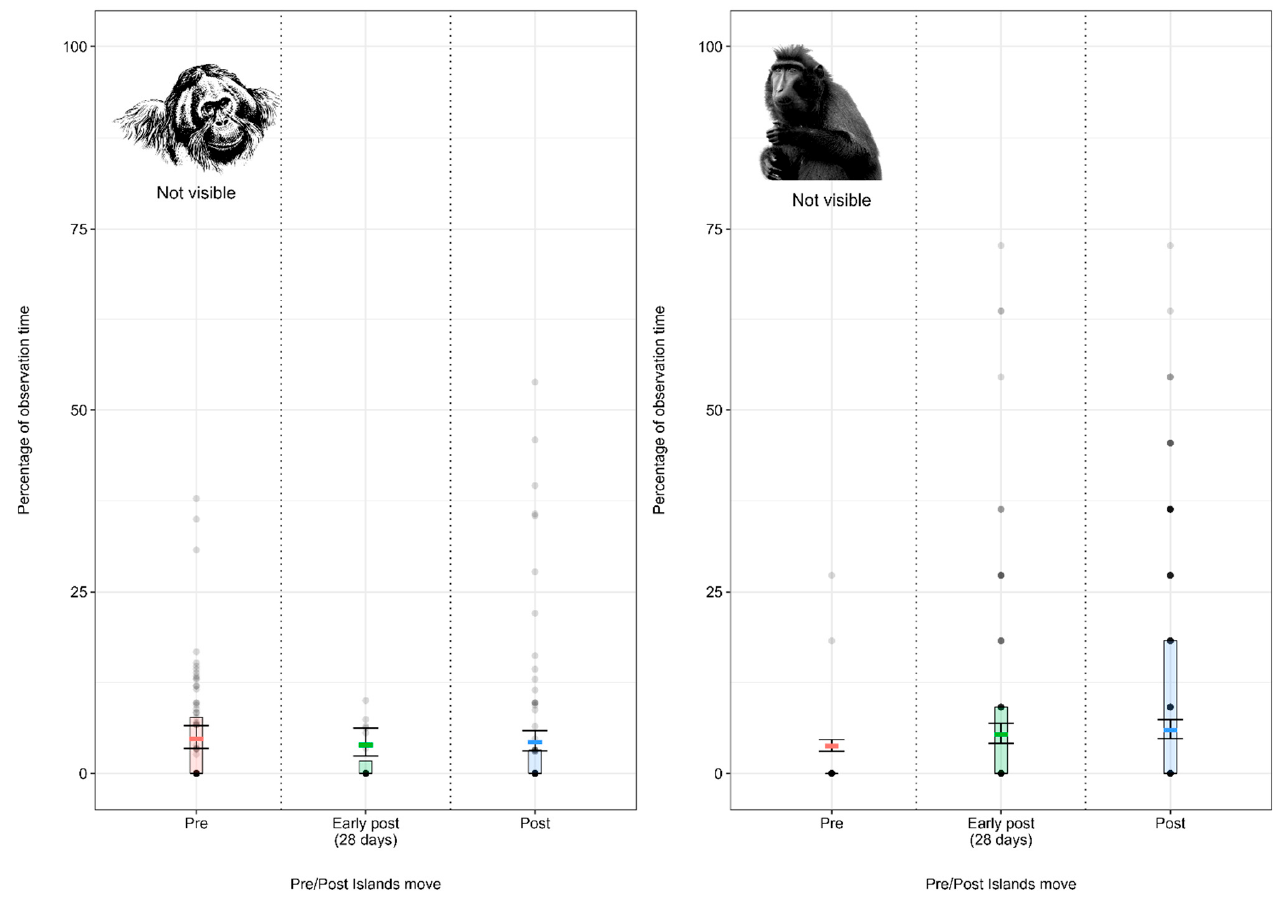
Figure 6. Proportion of the observation time (expressed as a percentage of the total observation time) Sumatran orangutans and crested macaques spent out of sight of observers/public under the pre-, early-post- and post-enclosure-move conditions. The model’s fitted values are represented by coloured horizontal lines, and their respective 95% confidence intervals are depicted as black error bars. Coloured boxes with black horizontal lines depict the medians and quartiles of the response. Grey dots represent raw data points, shaded according to frequency (dark indicates many observations, light indicates few).